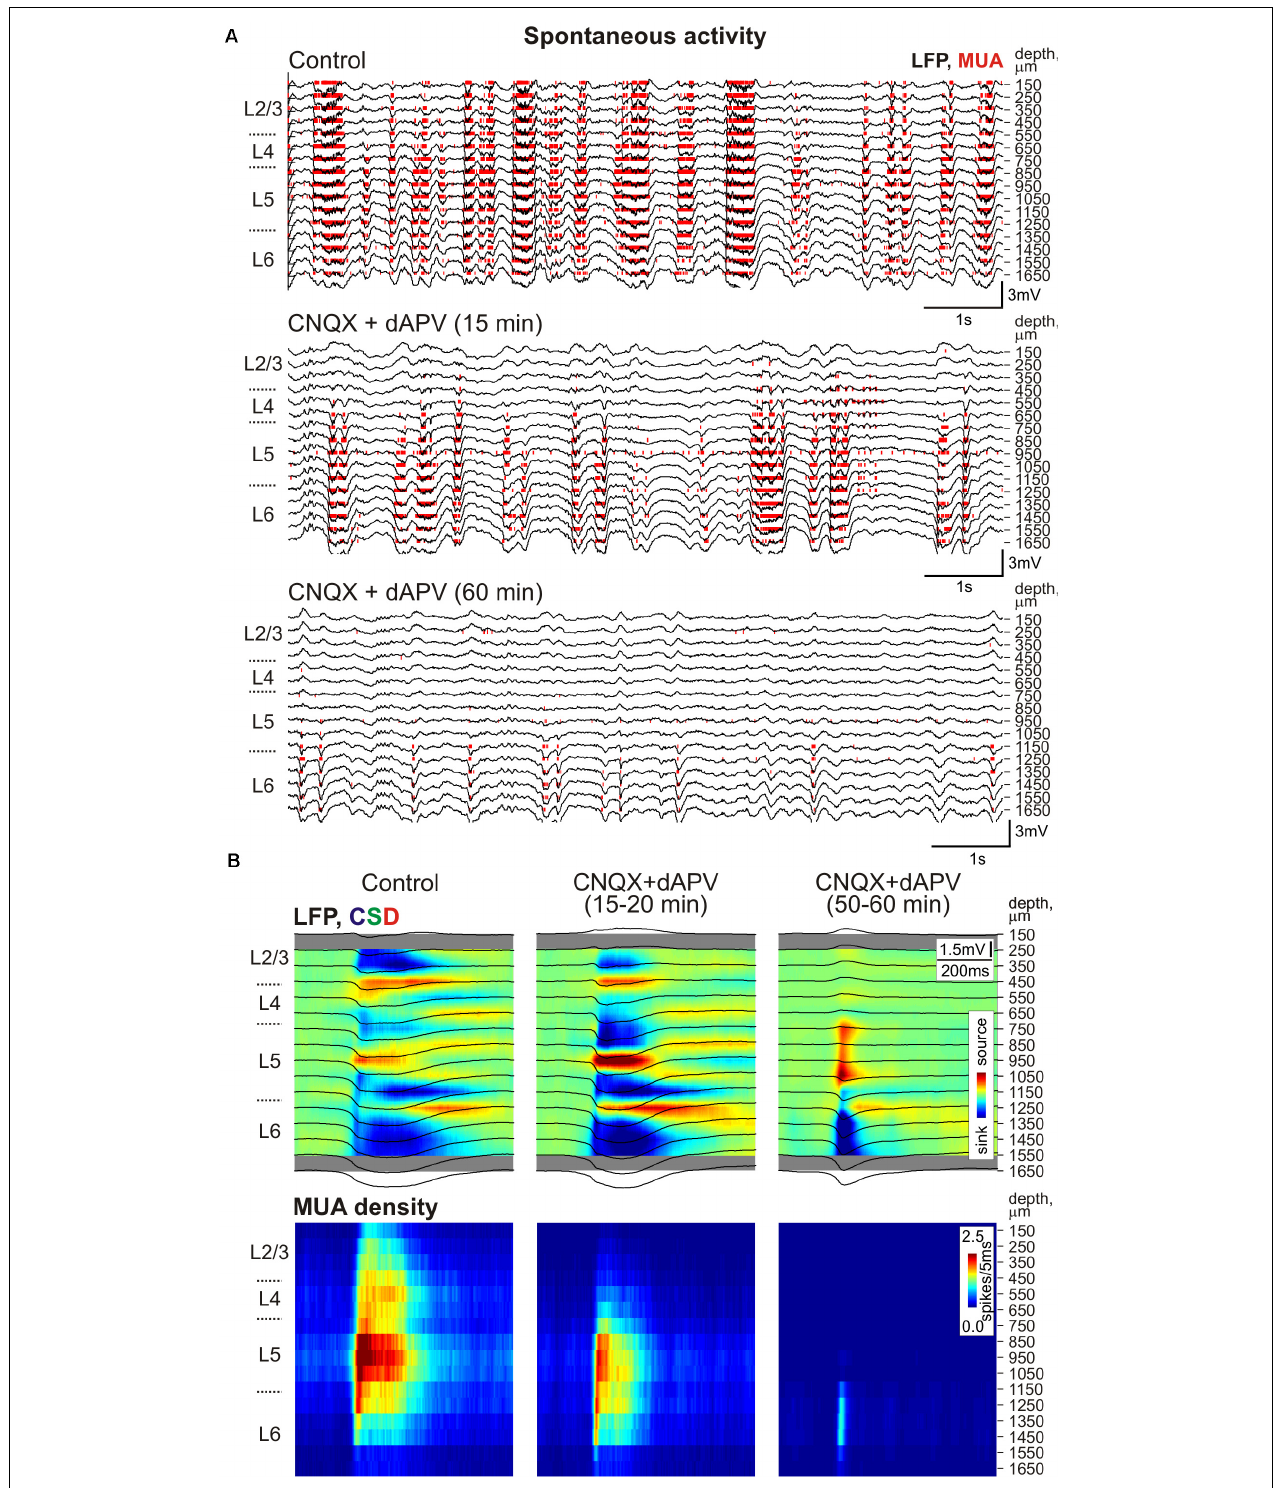
FIGURE 5 | The CNQX and dAPV action on spontaneous activity through the depth of the barrel column. (A) Example traces of 16-channel recording of barrel cortex activity in control ( top ), 15 min after epipial application of 500 µ M CNQX and 2 mM dAPV ( middle ), and 60 min after drug application ( bottom ). Red bars indicate detected spikes (MUA). (B) Corresponding current source density (CSD, upper panels ) and MUA density ( lower panels ) plots of averaged up-states recorded in control and after drug application (150 events were averaged for each condition). LFP traces (black) are overlaid on color-coded CSD plots. The cortical layer borders on (A,B) are shown left of the CSD and MUA density plots, and recording electrode depths are shown on the